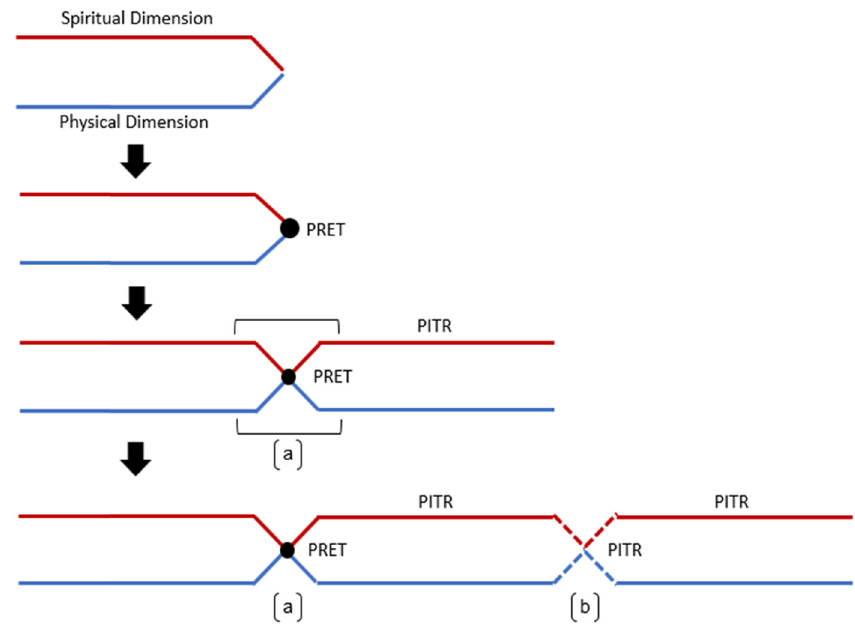
Figure 5: Linear process until the two dimensions become parallel again. In the fi gure, ( a ) signi fi es liminality and ( b ) signi fi es sustained reincorporation.